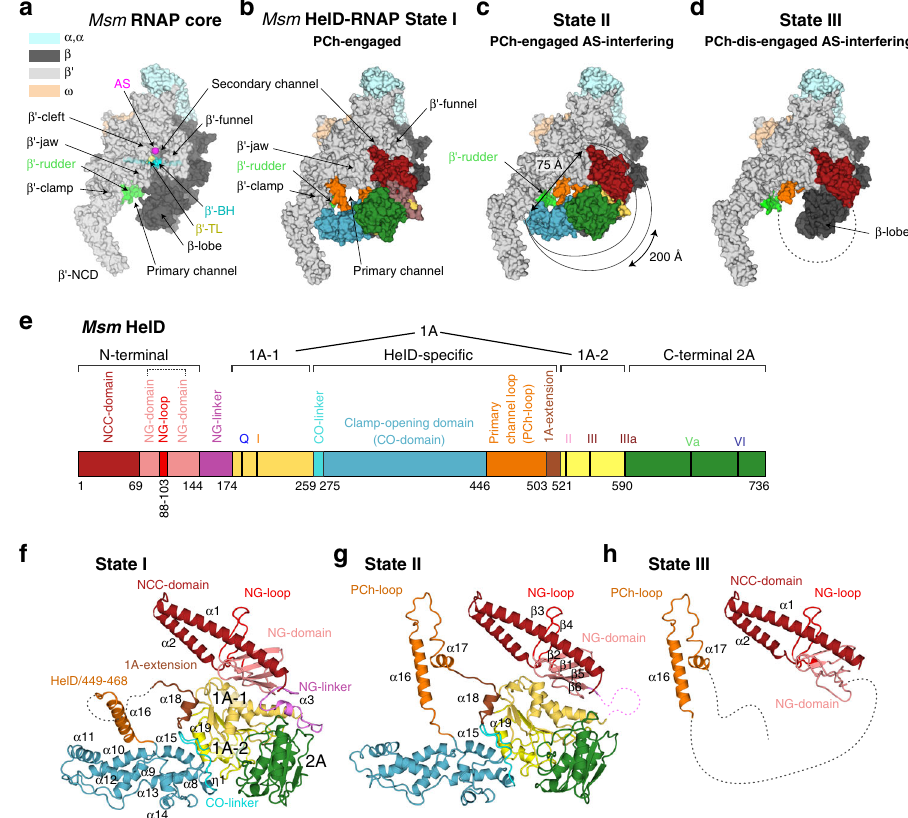
Fig. 1 Cryo-EM structures of Msm HelD – RNAP complexes. a Description of Msm RNAP core (PDB ID 6F6W) subunits and domains; RNAP subunits are color-coded according to the inset legend. b – d Atomic model surface representation of three identi fi ed Msm HelD – RNAP complexes: State I – PCh- engaged, State II – PCh-engaged AS-interfering, and State III – PCh-dis-engaged AS-interfering. When fully ordered in State I and II ( b , c ), the HelD protein (color-coded as in e ) forms a crescent-like shape, ends of which protrude to the primary and secondary channels of the RNAP core. The partly ordered HelD protein in State III ( d ) vacates most of the RNAP primary channel. e Schematic linear representation of the domain structure of the HelD protein. The 1A domain (two shades of yellow) is split in aa sequence into two parts, separated by a large HelD-speci fi c insertion (hues of blue and orange). The nucleotide-binding motifs are marked as vertical thick black lines. Aa numbering ( Msm ) is shown below. f – h Three states of HelD as observed in b – d color- coded according to the domain structure ( e ); secondary structure elements are marked as in Supplementary Fig.